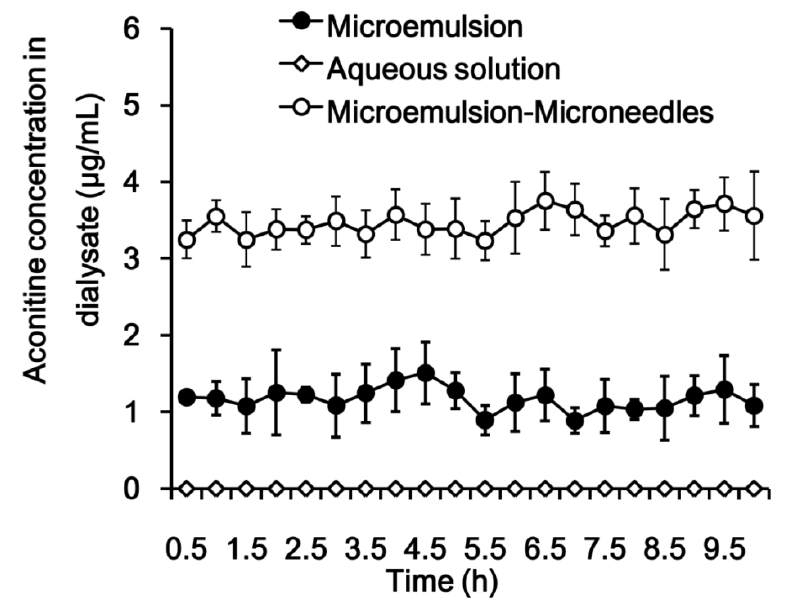
Figure 4. Aconitine concentration in deep skin tissue by using microdialysis sampling after application of aconitine-loaded microemulsion and aqueous solution to the abdominal skin of Sprague–Dawley rats in vivo ( n = 3).